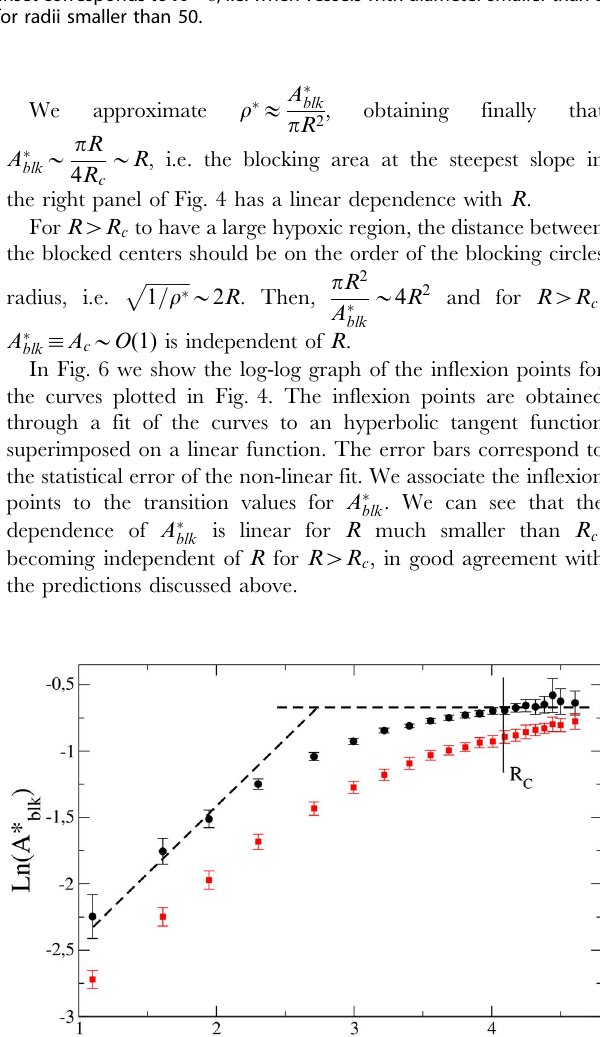
Figure 5. Irrigation, i.e. the density plot of c O , in different scenarios. a) one blocking circle with R ~ 80 , b) 50 blocking circles with R ~ 80 (arrows signal sites with no irrigation or vessel damage), c) 24 blocking circles with R ~ 25 (arrows signal areas in hypoxia resultant from the combined action of several blocking sites) and d) 153 blocking circles with R ~ 25 . For each plot, the blocked regions are in green, the local irrigation are represented by the color gradient, from black (lower) to red (higher) and the areas in white inside rectangle of interest have c O v C m , and are in hypoxia.